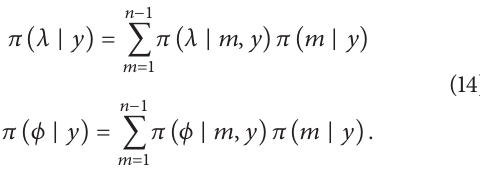
Table 4: Posterior probabilities for each model after omitting the year